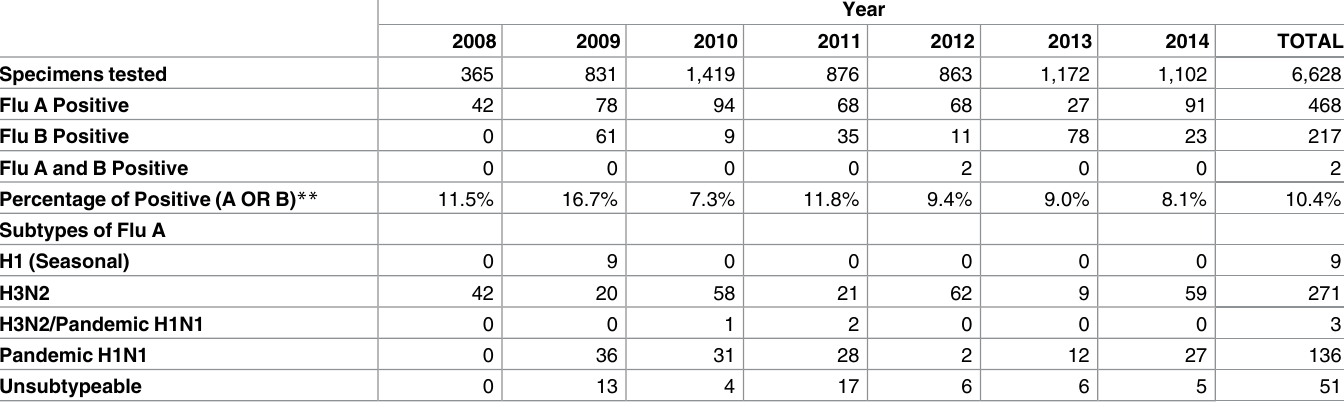
Table 3. Distribution of type and subtypes of influenza virus in Uganda from October 2008 to